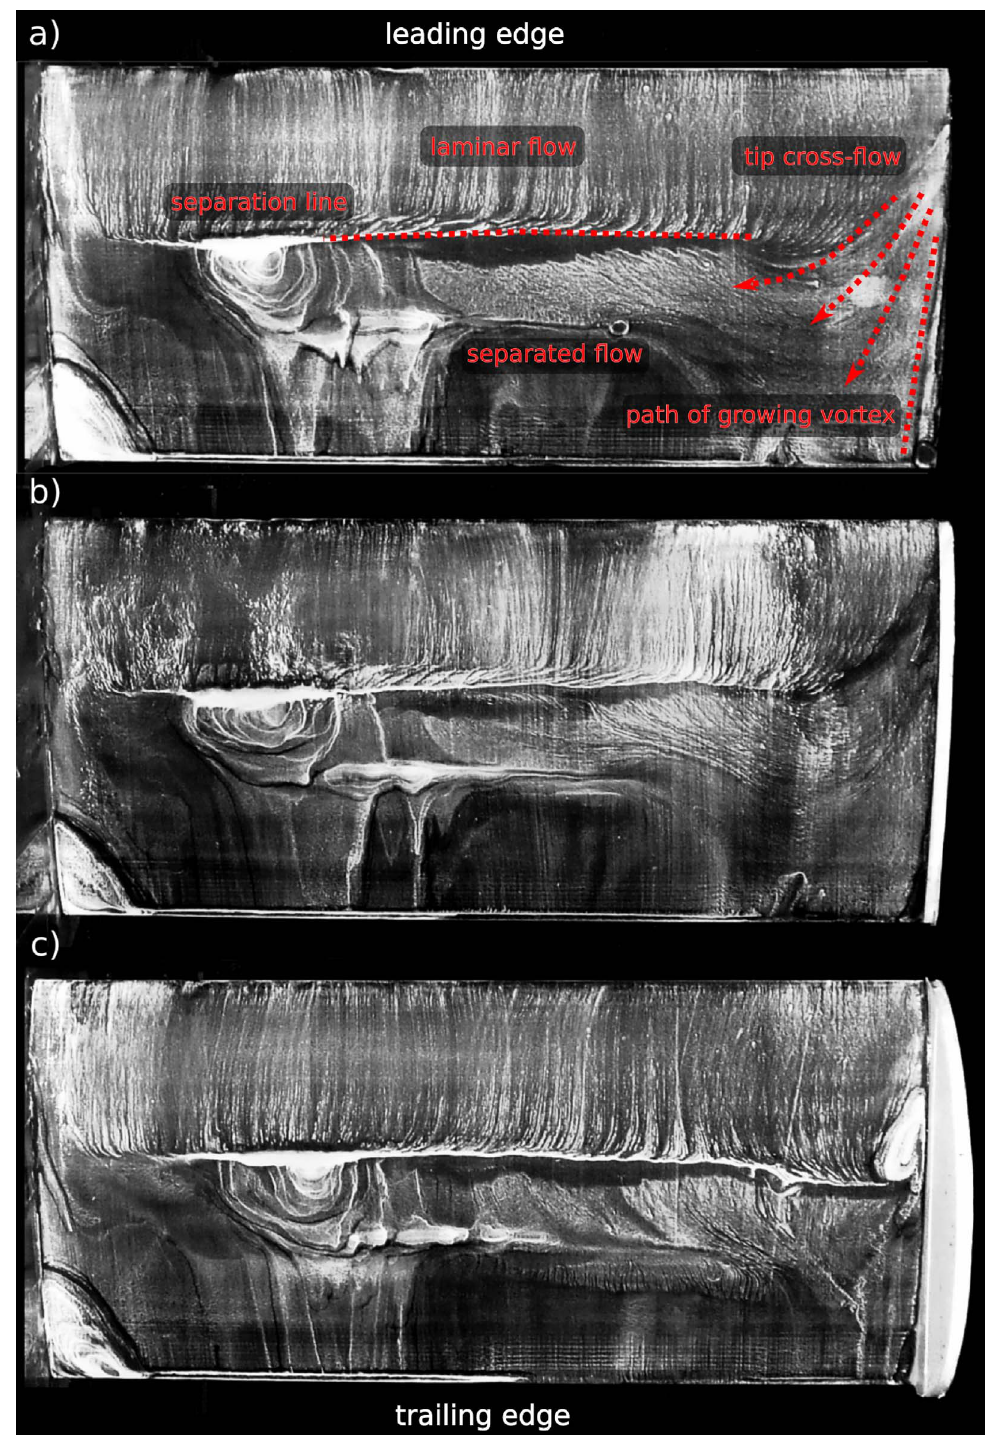
Figure 9. Surface fl ow visualization suction side NACA 4412 for Re = 150,000 and angle of attack 10 (cid:1) , fl ow from top to bottom, left side wall, right side free end, (a) baseline con fi guration, (b) end plate on the pressure side, (c) end plate on the suction